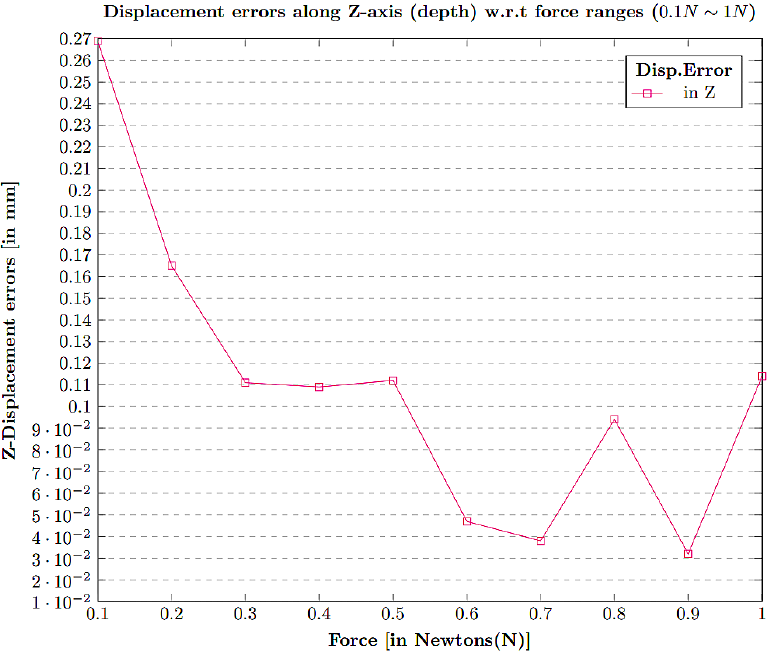
Figure 18. Displacement error in Z contact position w.r.t diverse force ranges 0.1 N ∼ 1